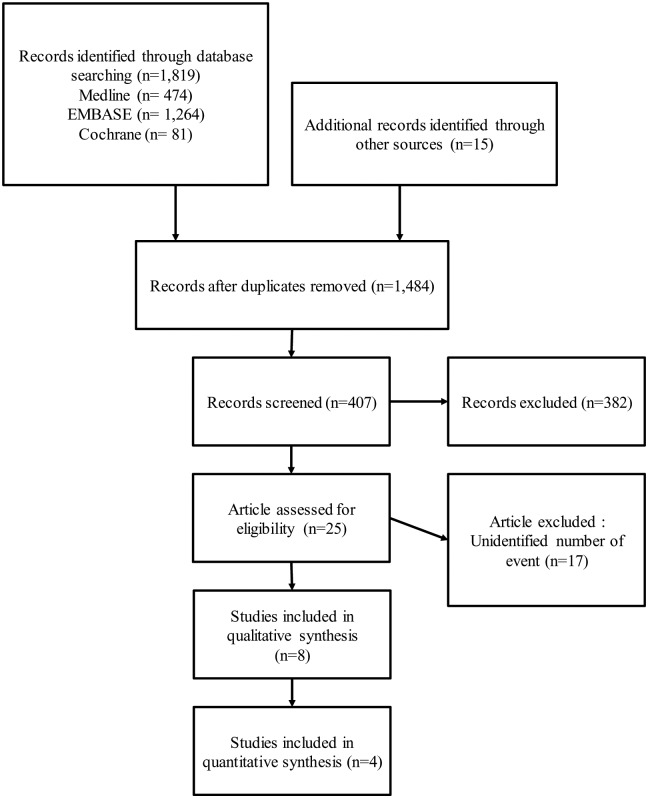
PRISMA flow diagram.Flow diagram demonstrating the process of article selection for systematic review and meta-analysis.